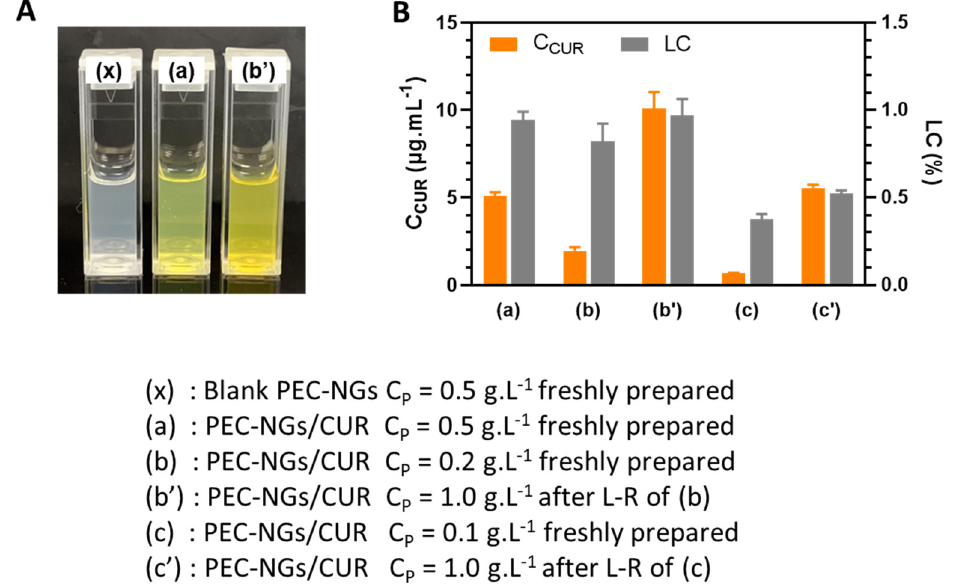
Figure 6. Blank or CUR-loaded HA-M2005/PLL PEC-NGs (n − /n+ = 2.5) before and after lyophilization and reconstitution (L-R) in PBS: ( A ) Visual aspect and ( B ) CUR concentration (C CUR ) and loading capacity (LC) ( n ≥ 3). Samples at C P = 0.5 g.L − 1 were retrieved from our previous work